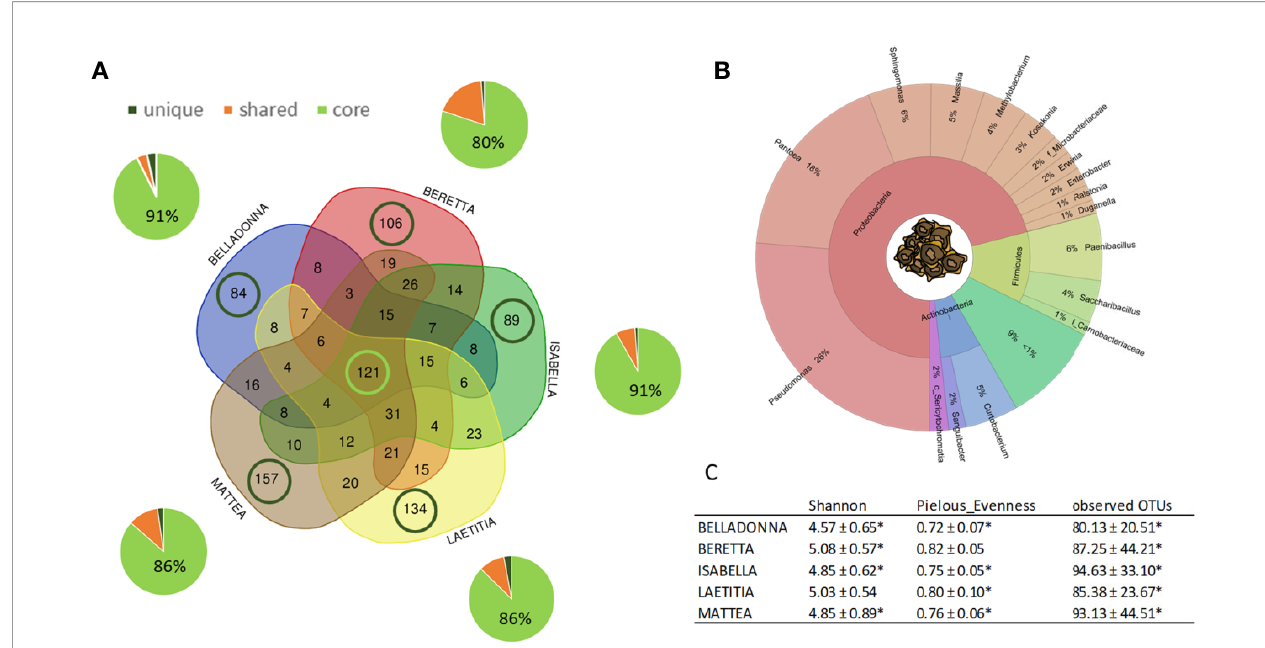
FIGURE 1 | Overview on microbial community of sugar beet seeds. (A) number (VENN diagram) and corresponding abundance (pie charts) of amplicon sequence variants (ASVs) found in sugar beet seeds. Light green: seed core, found in all cultivars; dark green: cultivar-speci fi c ASVs; orange: partially shared ASVs. (B) OTUs accounting for >1% relative abundance in the sugar beet seed microbial community on phylum and genus level. C: Alpha diversity indices of seed community; * = signi fi cantly differing according to Kruskal-Wallis test depending on seed origin (see also Figure 2